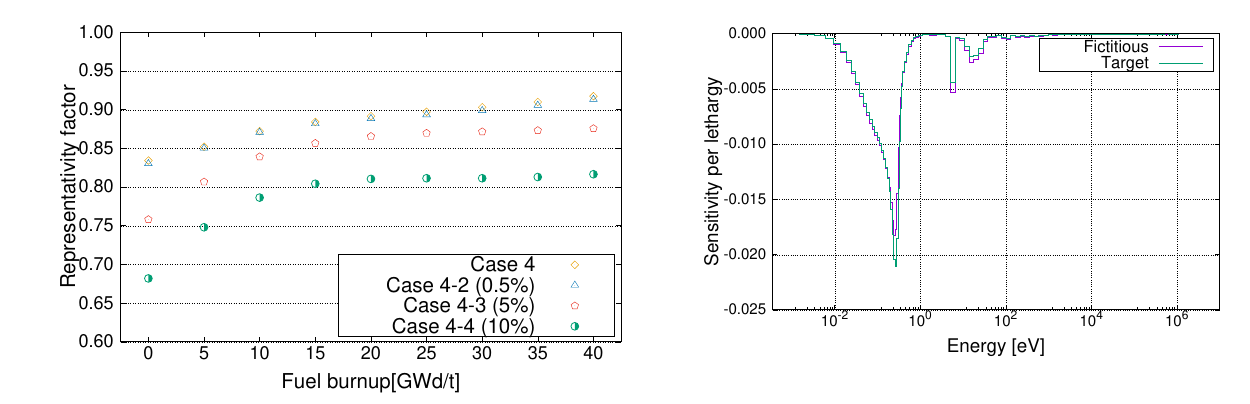
Figure 8. Maximum RFs of nuclide inventory data taking into consideration measurement error